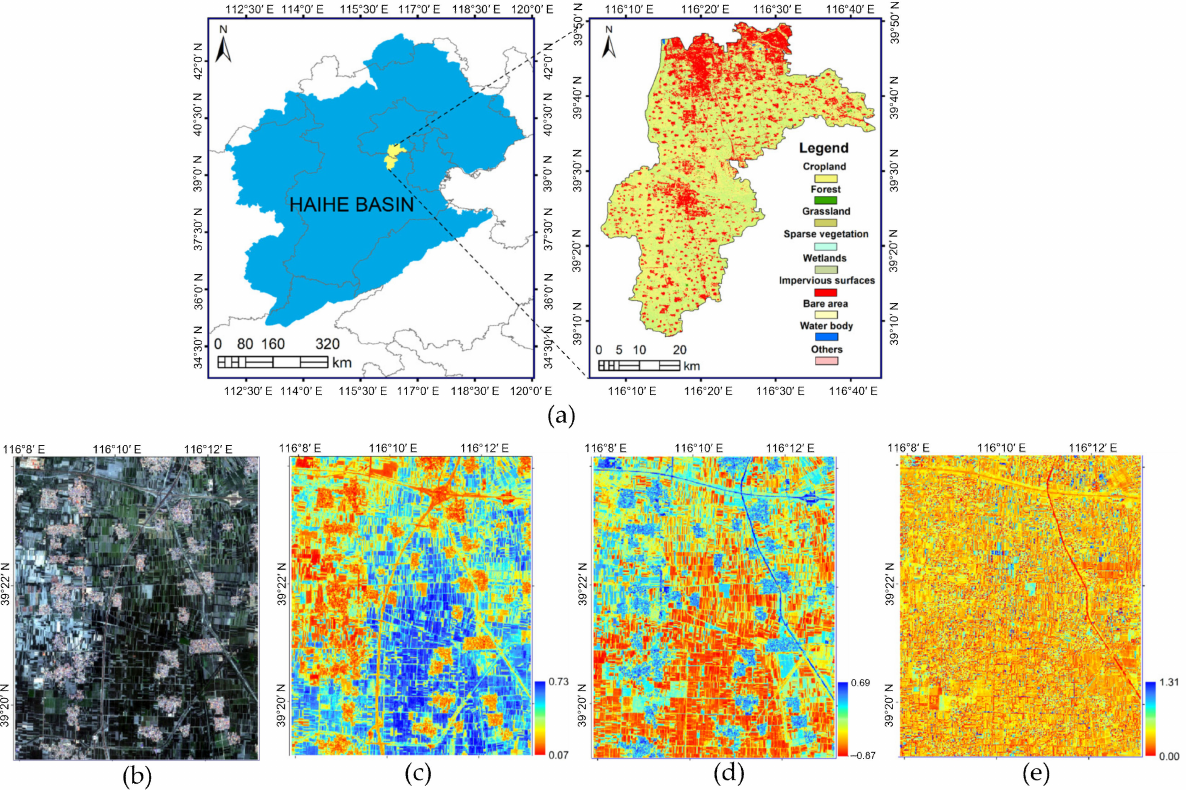
Figure 1. Satellite data of the study area: ( a ) relative location of the study area; ( b ) S2 image (in false-color composite: R = NIR, G = red, B = green), sample area from the study area; ( c ) NDVI calculated from an S2 image, sample area from the study area; ( d ) NDWI calculated from an S2 image, sample area from the study area; ( e ) MCARI calculated from an S2 image, sample area from the study